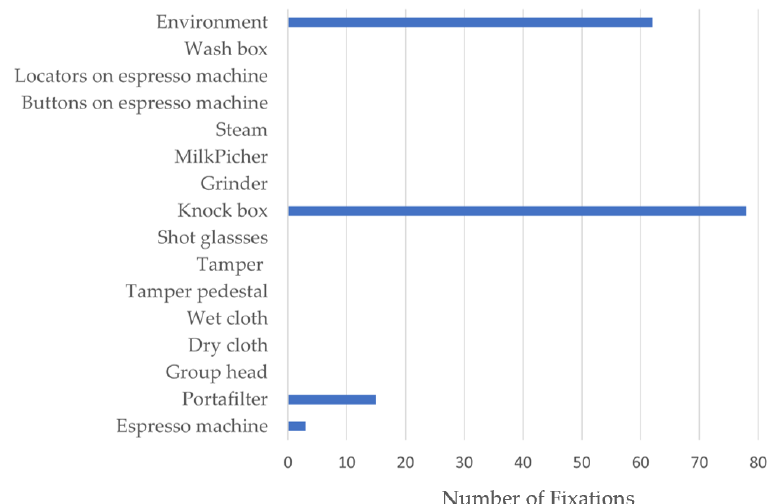
Figure 13. Example of the number of fixations on each object: Barista education, step 20, fail.